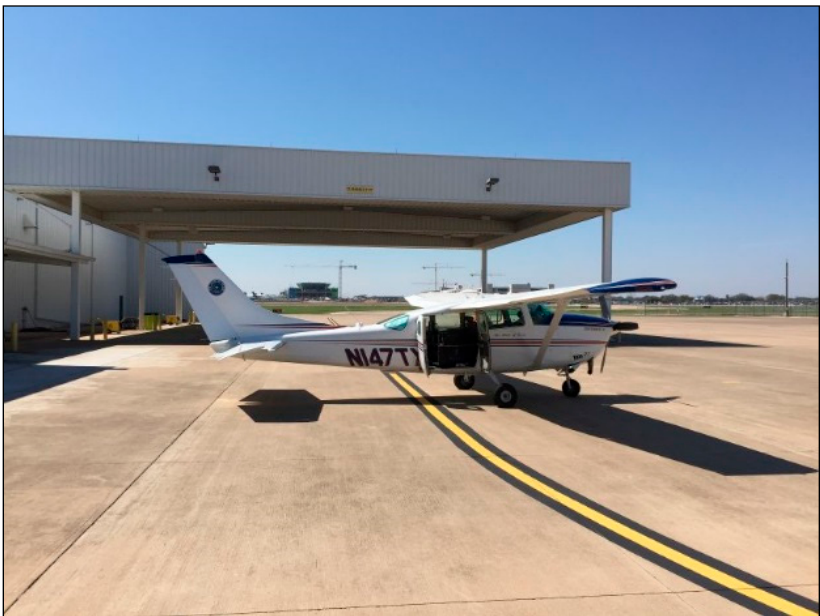
Figure 2. AHAB Chiroptera was installed in a Texas Department of Transportation (TxDOT) owned and operated Cessna 206 aircraft.